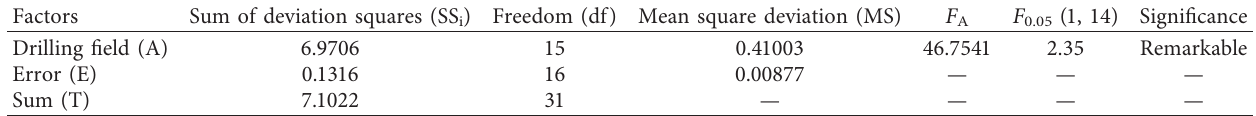
Table 3: Variance analysis of time factor experimental results.